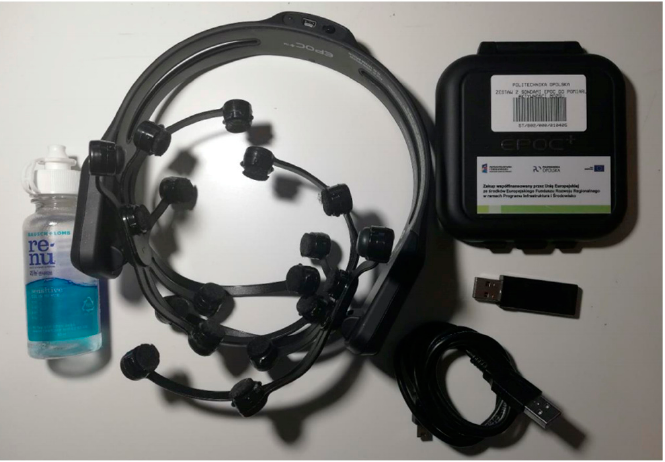
Figure 1. Emotiv EPOC+ NeuroHeadset.